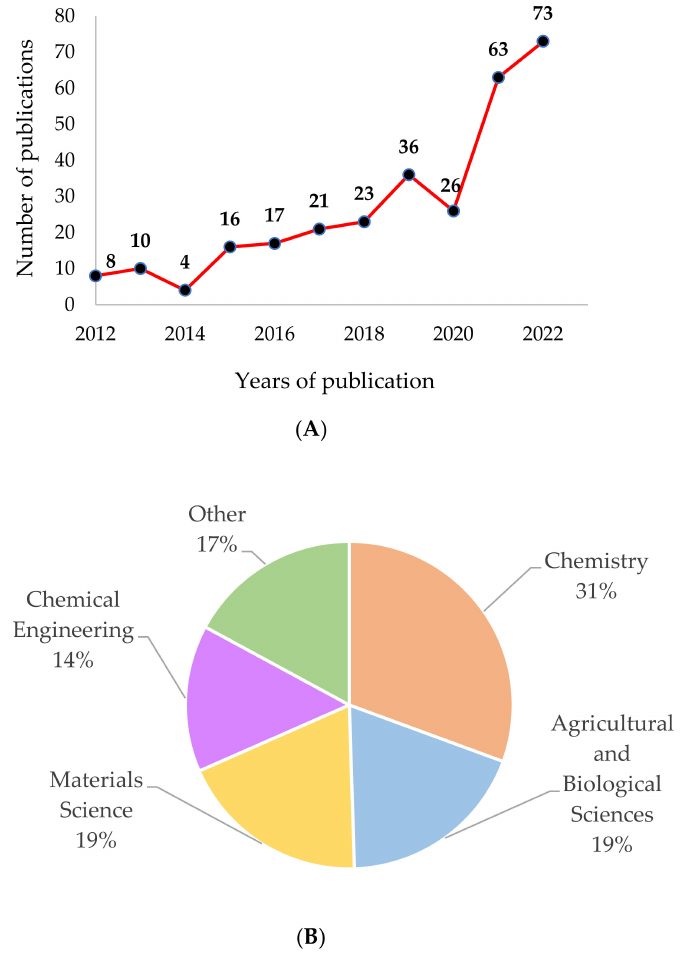
Figure 1. Evaluation of the scientific publications. ( A ) The number of publications registered on the topic of protein–polysaccharide food hydrogels over the last ten years; ( B ) the main subject area in which the publications registered on the topic of protein–polysaccharide food hydrogels over the last ten years (research carried out in the Scopus database in October